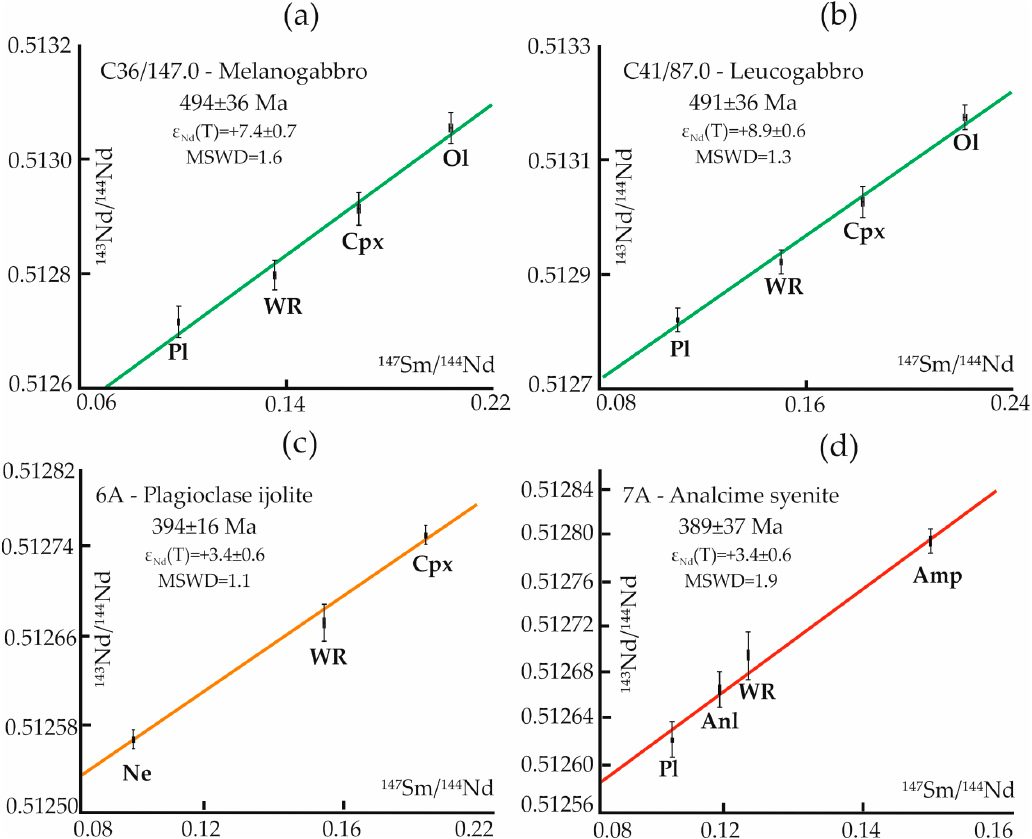
Figure 10. Sm–Nd isochrones for mineral separations and whole rock compositions of the University pluton and crosscutting N-S trending younger swarm of alkaline dikes [72]: ( a , b ) subalkaline melanogabbro (sample C36 / 147.0) and leucogabbro (sample C41 / 87.0) ca. 490 Ma; ( c , d ) plagioclase ijolite (sample 6A) and analcime syenite (globule) in fine-grained ijolite (sample 7A) ca. 390 Ma. Explanations of abbreviations see in Table